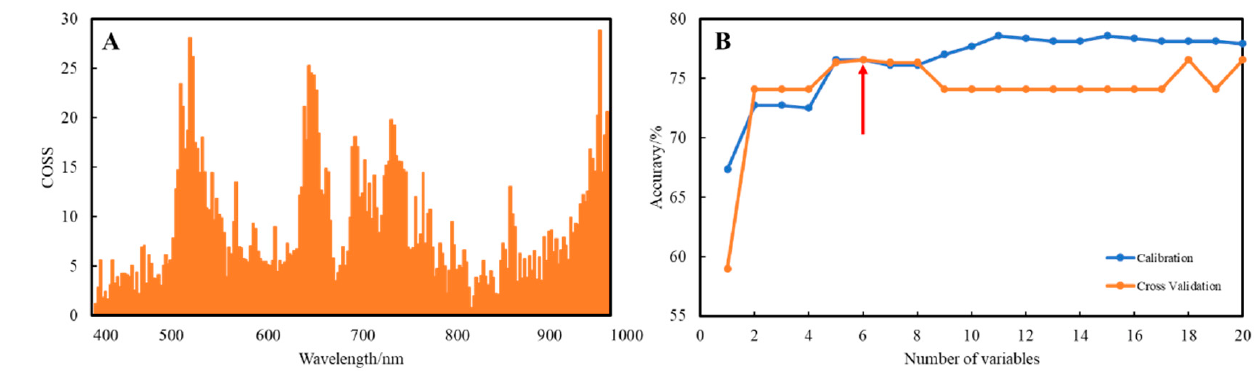
Figure 4. ( A ): COSS value computed by SPA for each waveband. ( B ): Calibration and cross validation classification accuracies at different number of variables based on PLS-LDA.